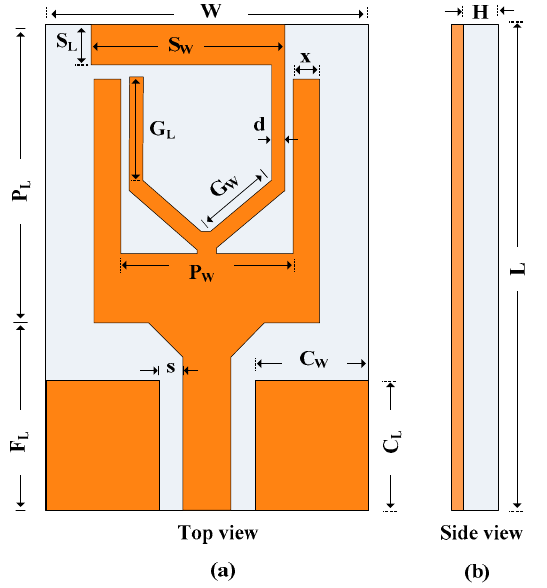
Figure 1. The geometry of the proposed WLAN Notch UWB antenna. ( a ) Top view, ( b ) side view. The following are the optimal dimensions of the proposed notch band UWB antenna: W = 10, L= 15, H = 0.254, P l = 9.2, Pw = 5.4, C L = 4, C W = 3.5, s = 0.75, x = 0.8, S L = 1.25, S W = 6, d = 0.4, G L = 3.19, and G W = 2.65 (All dimensions are in